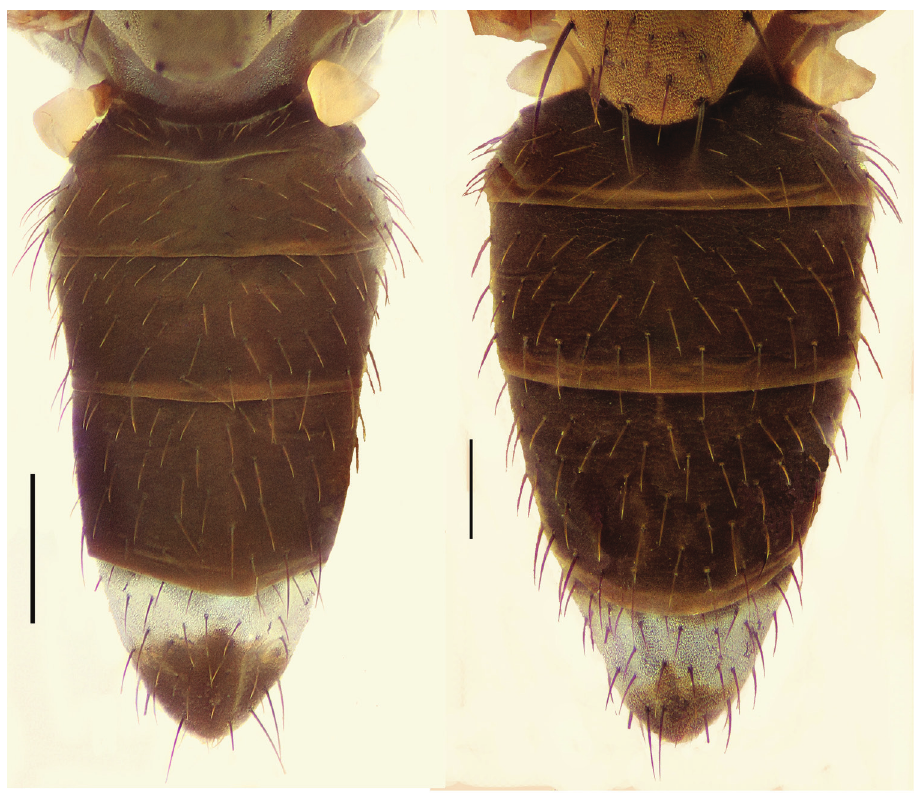
Figures 184–185. Abdomens of males, dorsal view. 184 Hydrochasma capsum sp. n. (Cuba. Sancti Spiritus: Topes de Collantes) 185 Hydrochasma leucoproctum (Loew) (St. Vincent: Cumberland Bay). Scale bar = 0.1